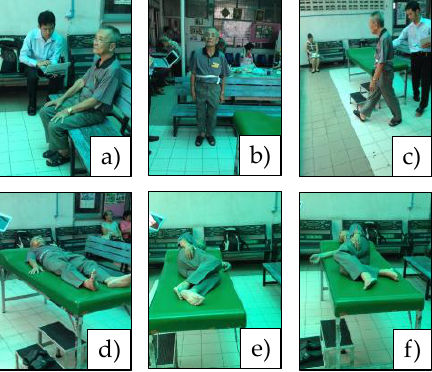
Figure 5. An elderly subject performing a sequence of six activities.